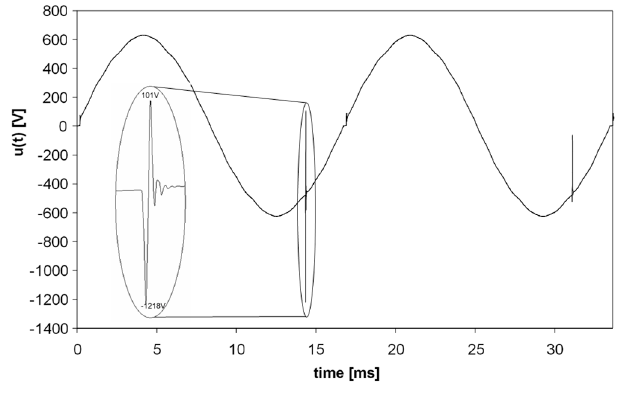
Figure 5. Example transient registered in a ship network [55].